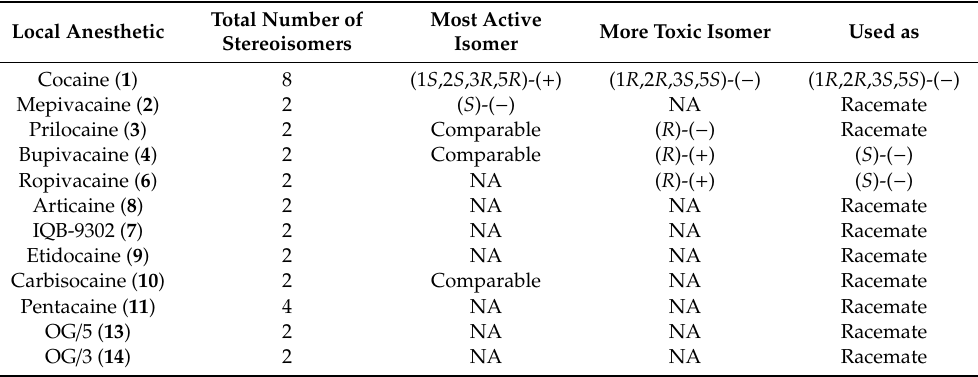
Table 4. Selected chiral local